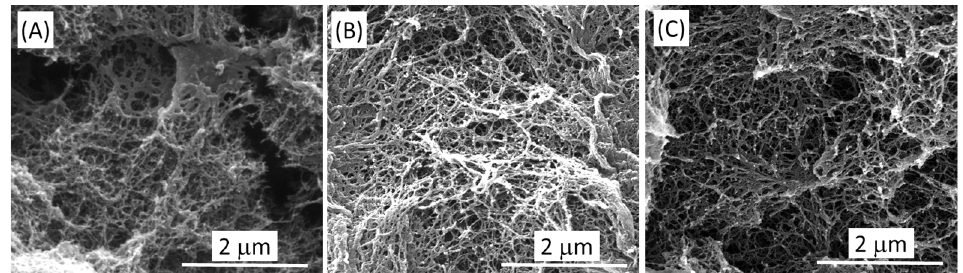
Figure 2. SEM images of unsulfonated ( A ), sulfonated with S = 9% ( B ), and sulfonated with S = 25% ( C ) PPO aerogels.